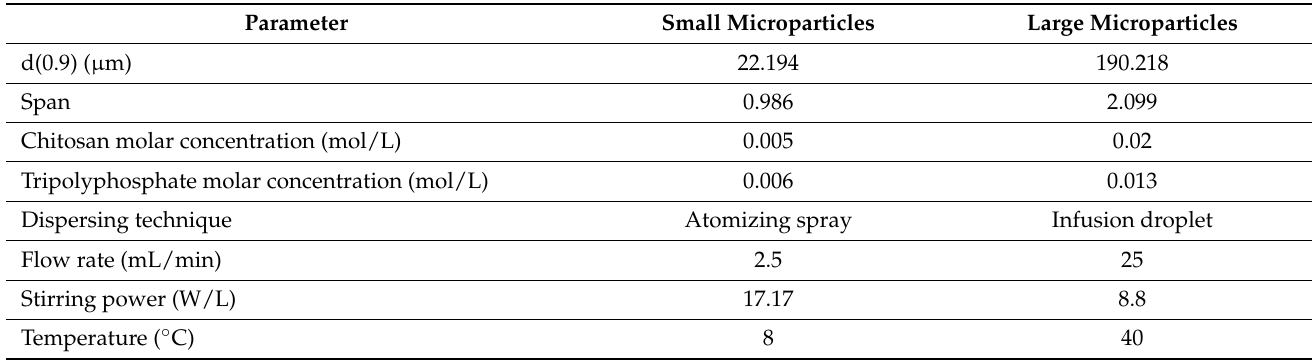
Table 2. Particle size (d(0.9)) and size distribution (Span) values for two target microparticles obtained from ionic gelation with specific